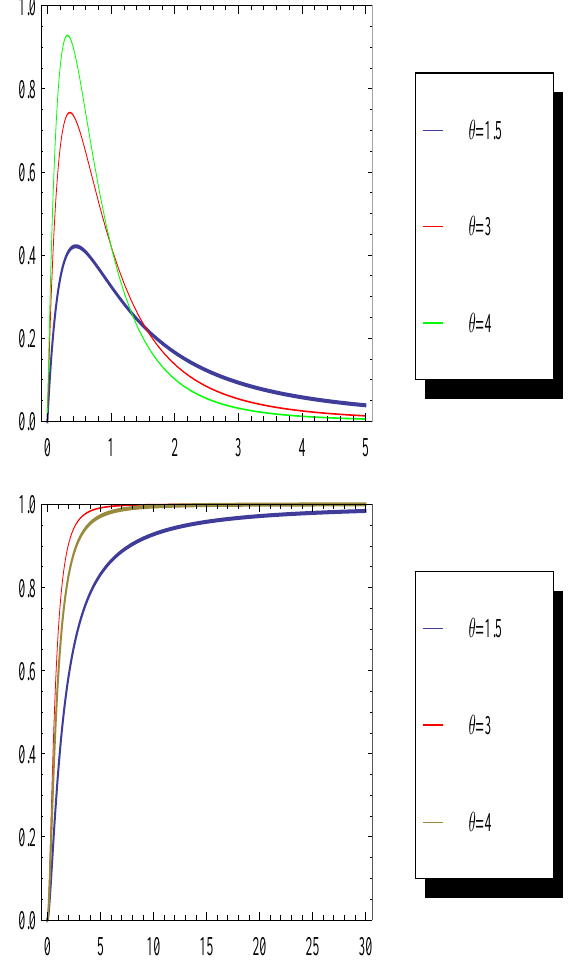
Figure 1. Plots of PDF and CDF